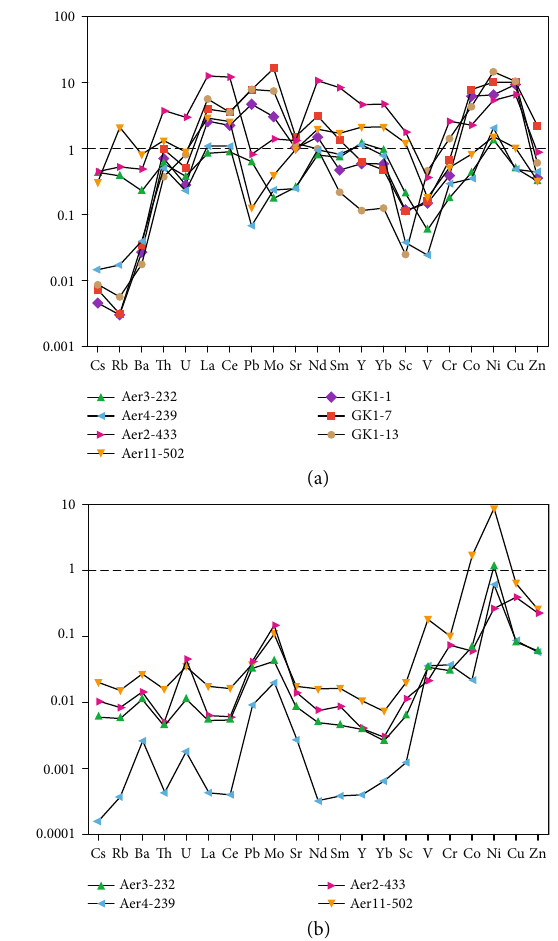
Figure 7: Trace elements concentrations in isolated organic fractions ((a) kerogen and (b) extract fractions) of mudstones normalized to corresponding whole